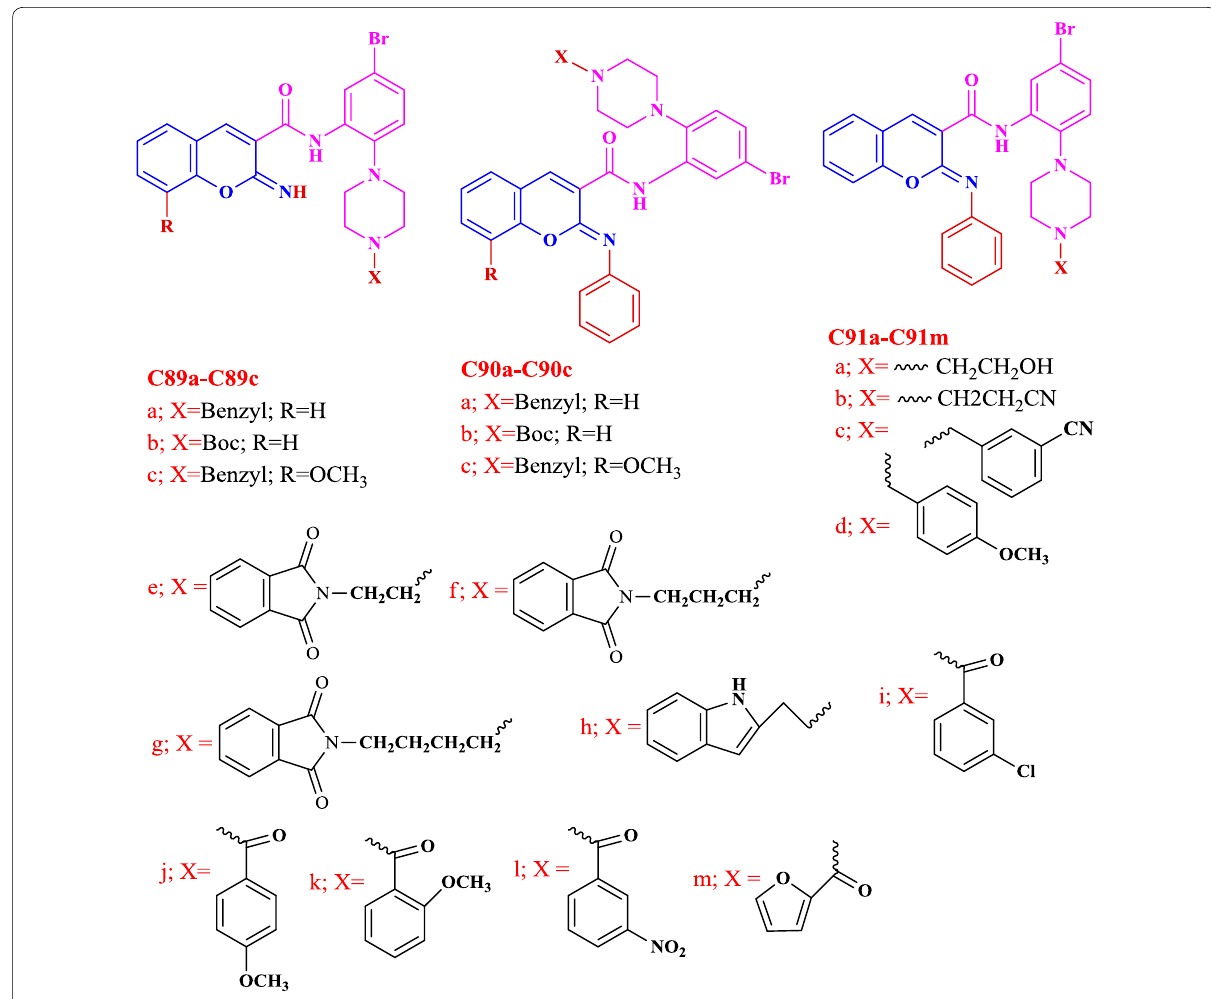
Fig. 76 Molecular structure of compounds C89a – c and C90a – c and C91a –